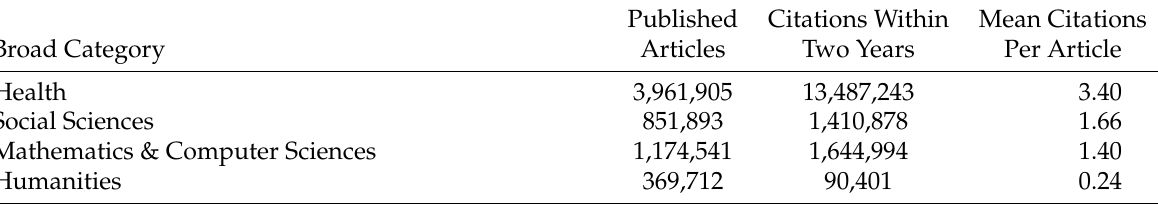
Table 1: Published articles, 1996–2014, and citations within two years of